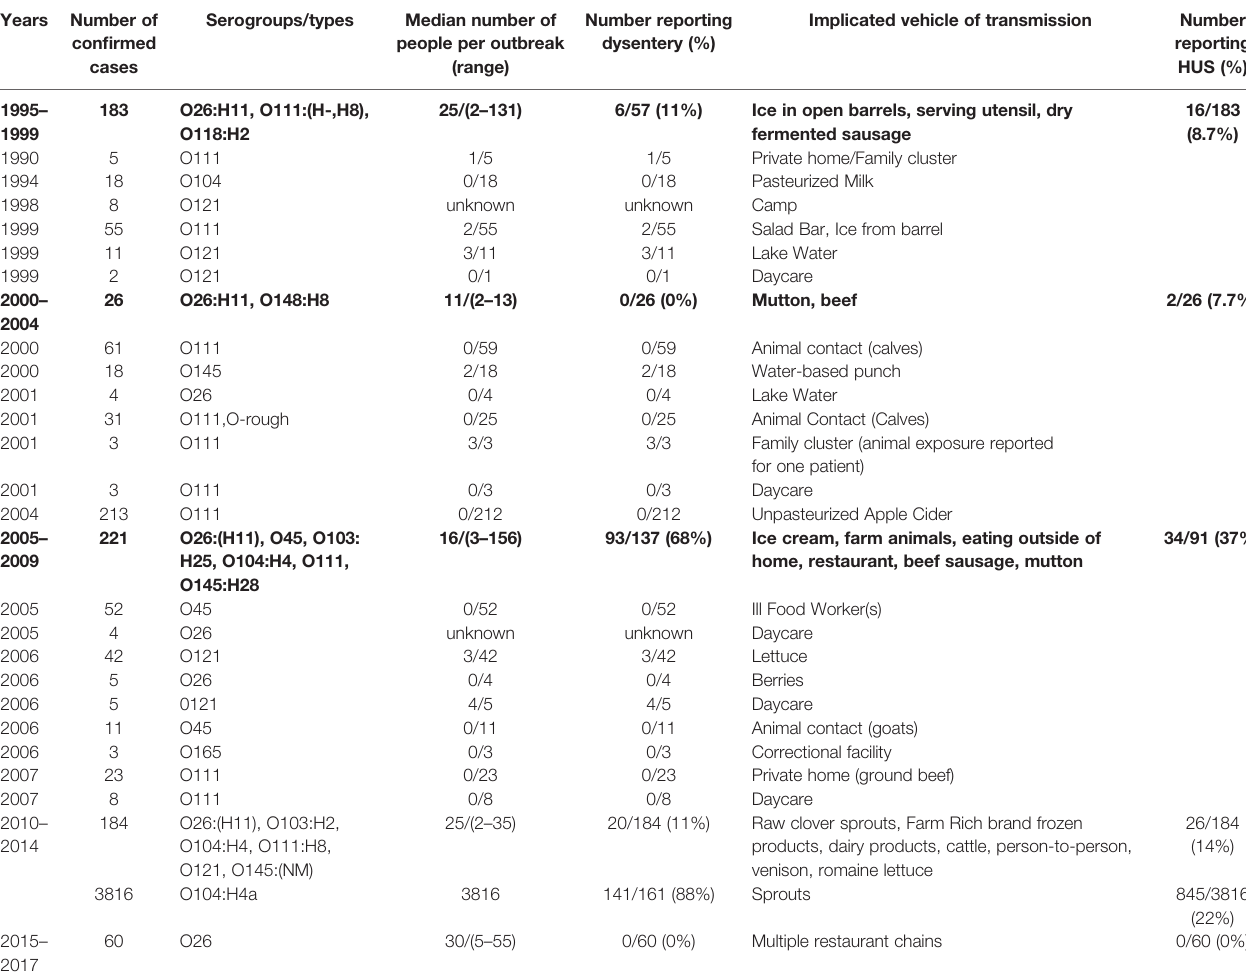
TABLE 1A | A description of the global reports of outbreaks of two cases or more of non-O157 strains of Shiga toxin-producing E. coli along with the reported frequency of dysentery and hemolytic uremic syndrome where these data were available, and the implicated vehicle of transmission, 1995 ֲ 017. (Copyright obtained from Valilis et al., 2018).